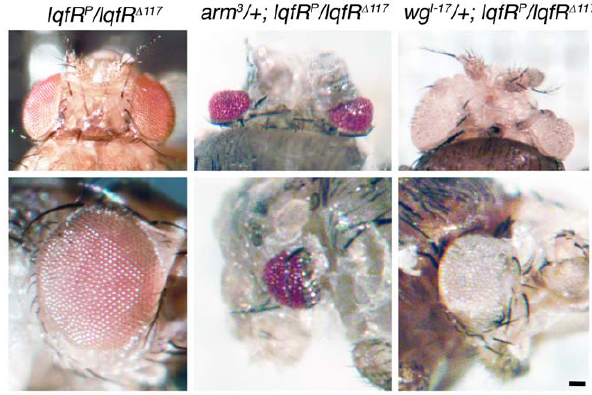
Figure 4. Genetic interactions between lqfR , armadillo , and wingless . Shown are light microscope images of adult fly heads (dorsal view, top row), and eyes (bottom row). The genotypes of each column are indicated at top. The same fly is shown in the top and bottom rows. scale bar: , 50 m m.